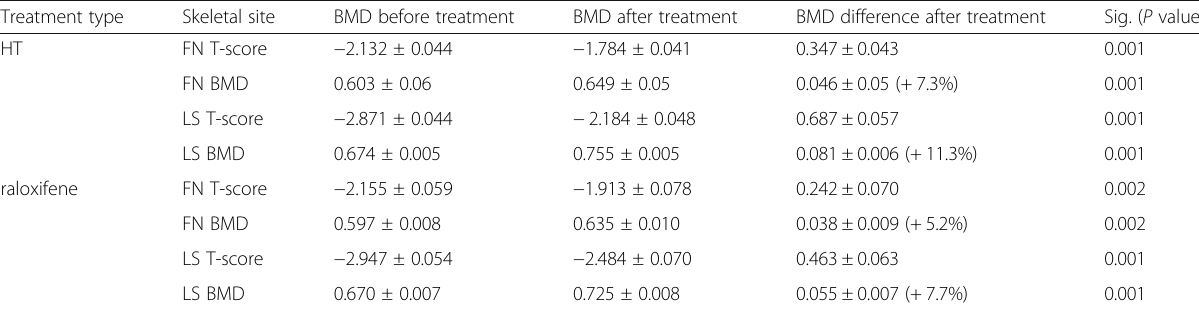
Table 5 The effect of a treatment type on BMD change Treatment